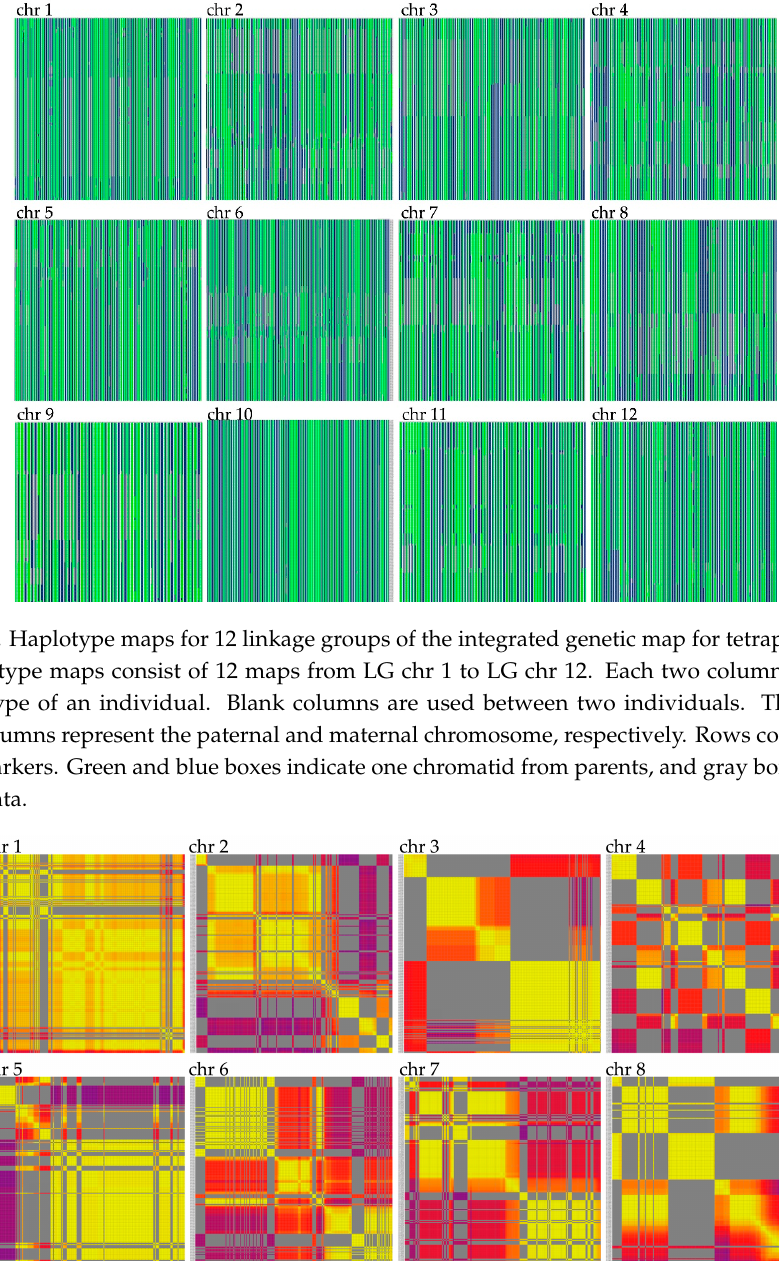
Figure A1. The SNP distribution on the potato genome. The x -axis represents the chromosome length and the y -axis indicates the chromosome code. Each band represents a chromosome, and the genome is divided according to the size of 1 M. The more SNPs in each band, the darker the color; the smaller the number of SNPs, the lighter the color. The darker areas in the figure are the areas where SNPs are concentrated.